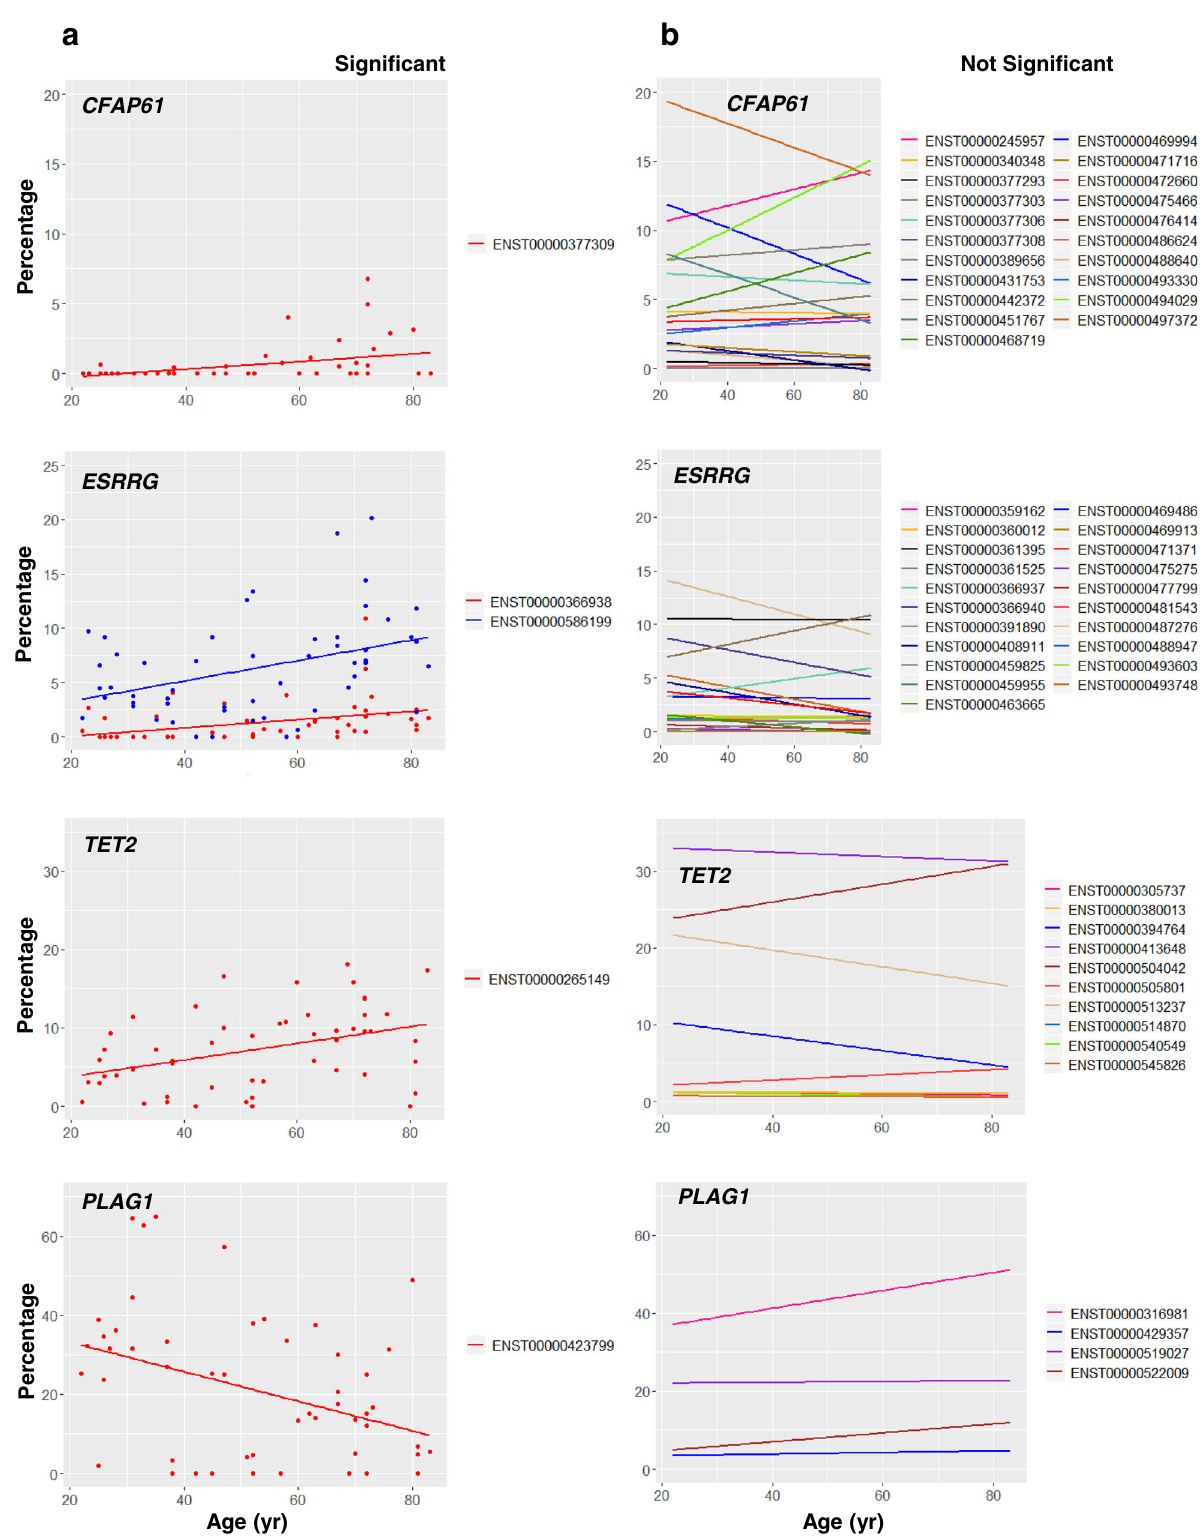
Fig. 6 Differential transcript usage analysis for top RNAs (ENSGs). Among the RNAs in the four top 20 lists, CFAP61 , ESRRG , TET2 , and PLAG1 mRNAs were identi fi ed to have splice variants with statistically signi fi cant changes in differential transcript usage with age. a Change in differential transcript usage for all signi fi cant variants of the four mRNAs (all p < 0.05 from two-sided, unadjusted Wald tests). b Change in differential transcript usage for all nonsigni fi cant variants of the four RNAs, provided for comparison (all p > 0.05 from two-sided, unadjusted Wald